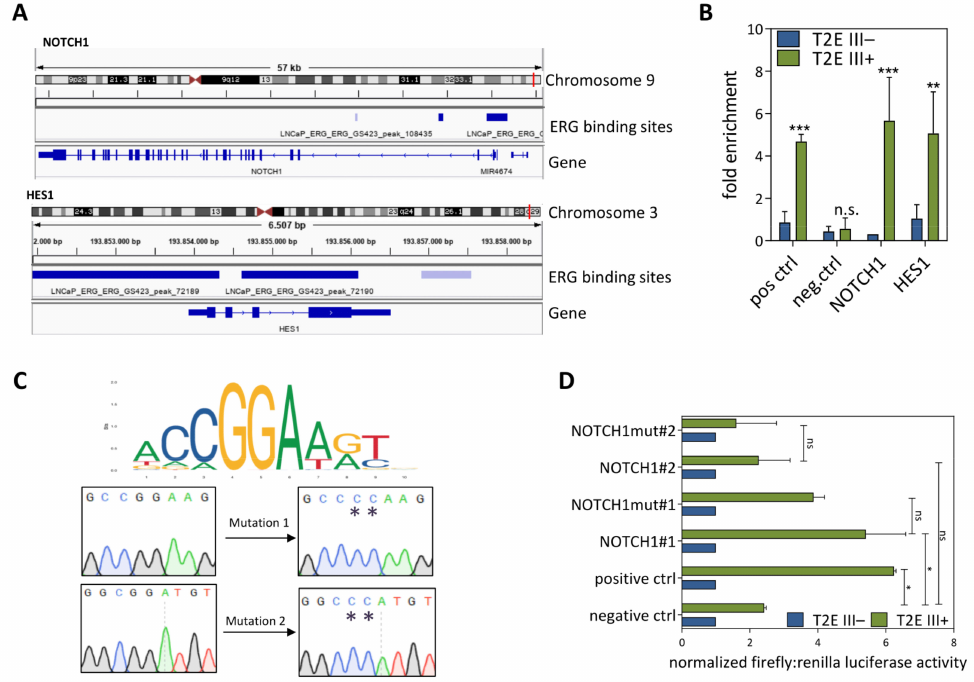
Figure 6. The transcription factor ERG binds to NOTCH1 and HES1 promoter regions. ( A ) Chromosomal locations of NOTCH1 and HES1 and ERG ChIP-seq binding sites displayed in the IGV browser (ChIP-Seq data from [48]). ( B ) ERG ChIP-qPCR of NOTCH1 and HES1 promoter regions in LNCaP T2E III cells induced with PBS ( − ) or doxycycline (+). ( C ) Mutation insertion in NOTCH1 promoter regions. Jaspar [49] annotated ERG binding site sequence logo and Sanger sequencing results of wildtype and mutated NOTCH1#1 ( top ) and NOTCH1#2 ( bottom ) ERG binding sites. ( D ) Normalized firefly:renilla luciferase activity of the different NOTCH1 , mutated NOTCH1 , and control promoter regions in control (blue) and doxycycline (+, green) treated LNCaP T2E III cells (n.s. not significant, * p ≤ 0.05; ** p ≤ 0.01; *** p ≤